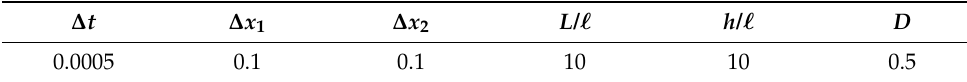
Table A2. Numerical values for two-dimensional simulation. ∆ t ∆ x ∆ x 2 L / (cid:96) h / (cid:96) 1